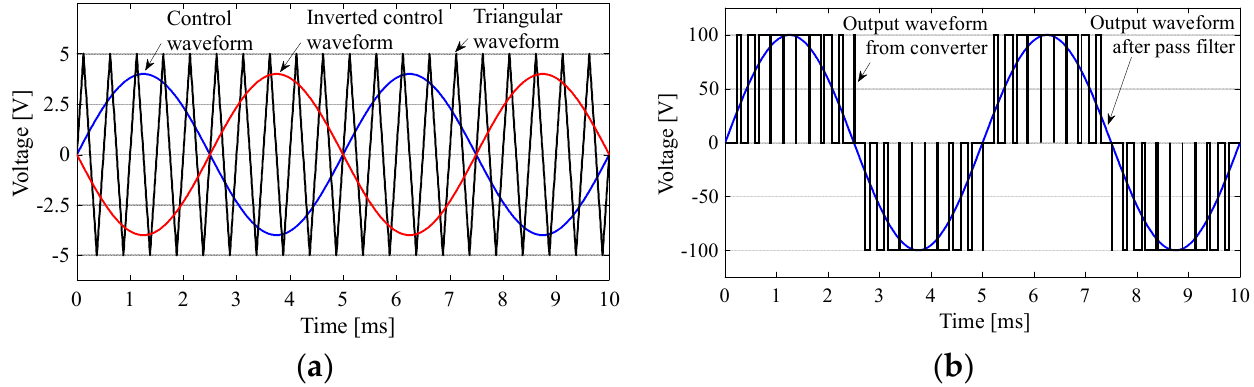
Figure 7. Controlled signals and output voltage waveform of the PWM converter: ( a ) controlled signals; ( b ) output voltage waveform.